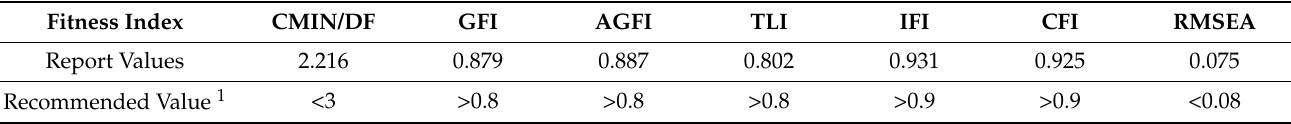
Table 6. Modified structural equation fitting